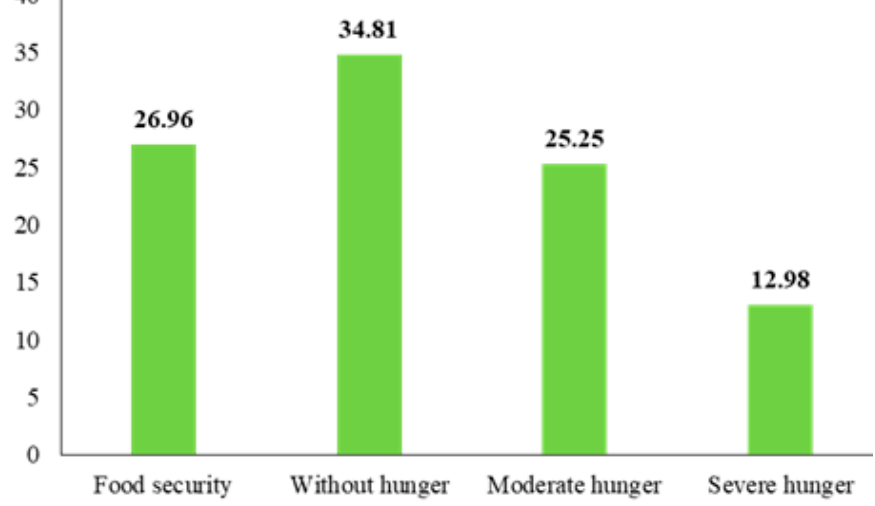
Figure 2. The situation analysis of households’ food security.